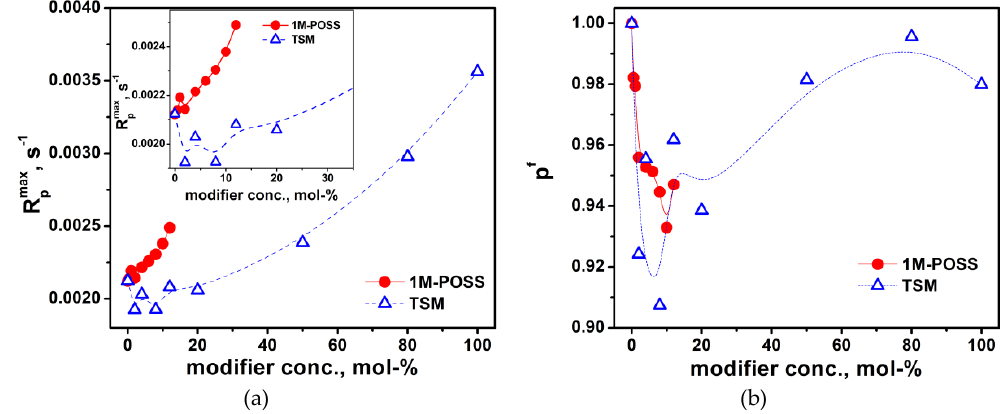
Figure 7. The dependence of ( a ) the maximum polymerization rate, R pmax , and ( b ) the final conversion of double bonds, p f , at 40 °C on the modifier content. The lines are eye guides.